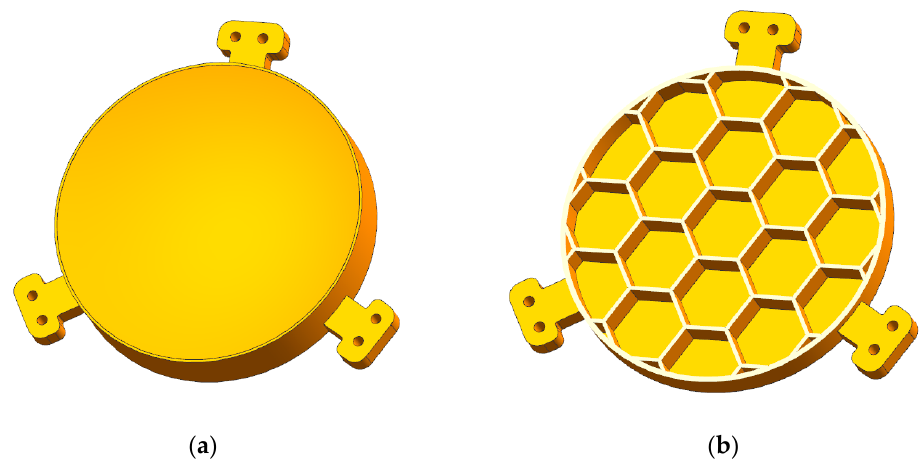
Figure 4. ( a ) The honeycomb mirror. ( b ) The half-cutaway view of the honeycomb mirror.